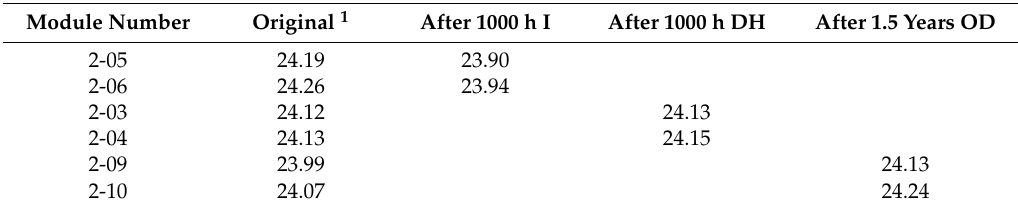
Figure 6. EL image at 100% I SC of a test module with a defective cell interconnection in the original state. Table 3. Power output in [W] at P MPP (measured under STC conditions) of the test modules with defects in the cell interconnection system before and after ageing.